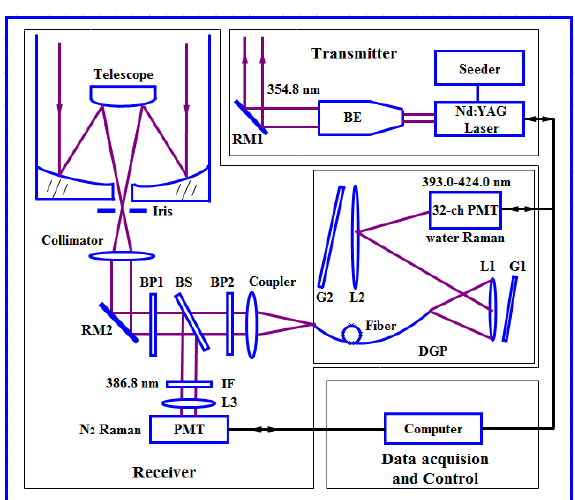
Fig. 1 Schematic layout of the spectrally-resolved Raman lidar. BE, beam expander; BP, bandpass filter; RM, reflecting mirror; BS, beam splitter; IF, interference filter; L, lens; G, grating; PMT, photomultiplier